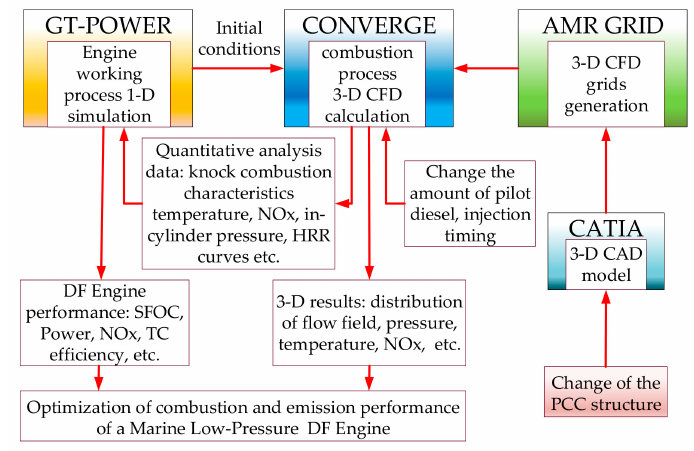
Figure 2. Calculation simulation flow chart.